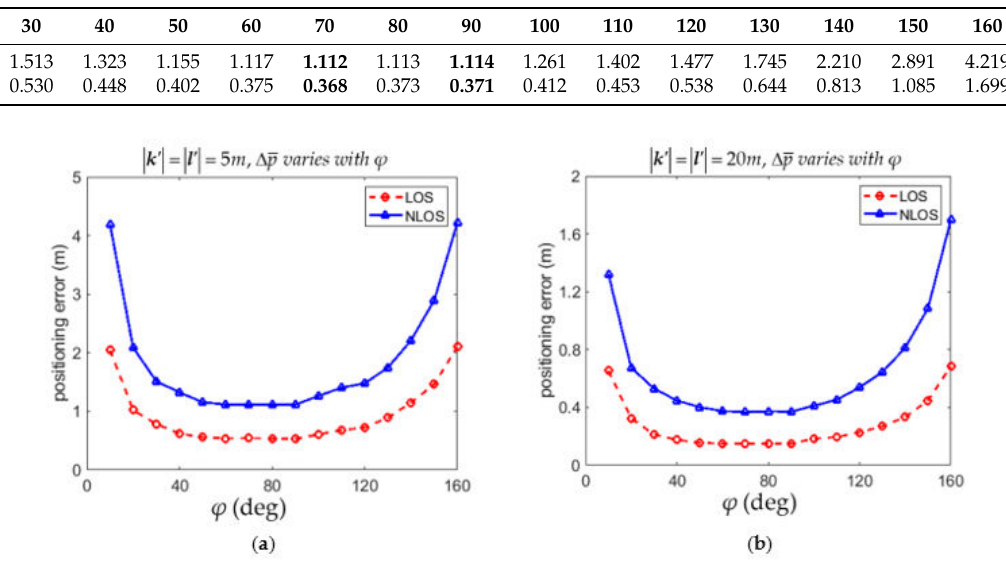
Figure 5. Variation of 2D RMSPE ∆ p with angles ϕ for the LOS and NLOS conditions. ( a ) The environment of 5 m × 5 m . ( b ) The environment of 20 m × 20 m .